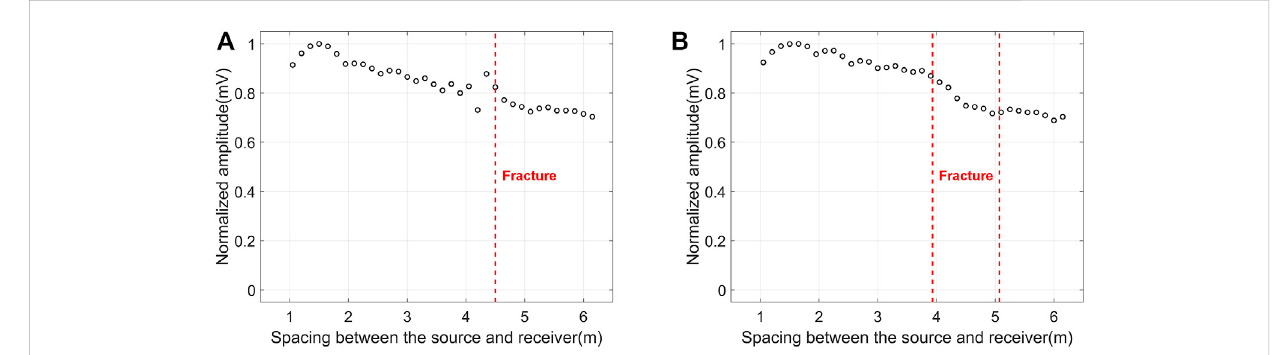
FIGURE 10 NormalizedamplitudeofdipoleSwaveversussource-receiverspacing.Thefracturewidthis40 mmand fi lledwithcalcite. (A) Thefracturedipangle is 90 ° , red dotted line stands for the position where thefractureintersected with theborehole; (B) The fracturedip angle is 10 ° , red dotted lines stands for the positions where the fracture intersected with the borehole.